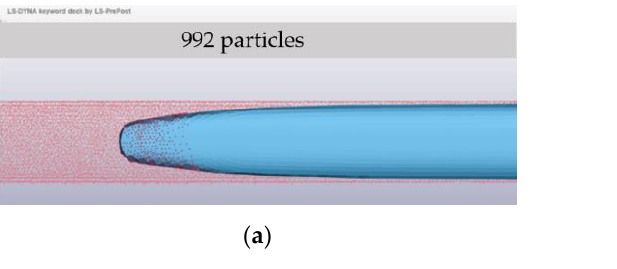
Figure 10. These are the two working conditions of Scenario 2: ( a ) conditions in the fifth-level sea state when waves hit the hull, and ( b ) conditions when the fifth- level sea state’s sea spray particles settle.